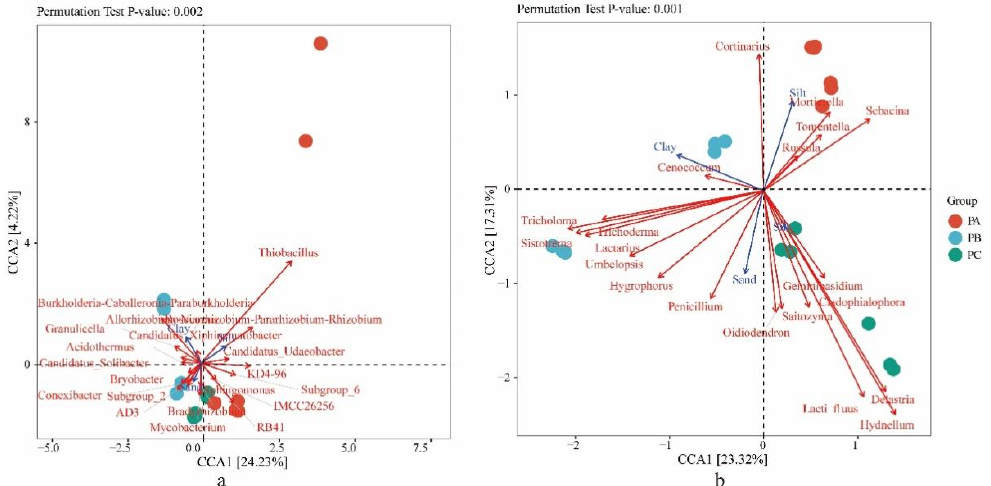
Figure 5. The relationships of soil texture factors with ( a ) bacteria and ( b ) fungal communities in soil with different collection sites. PA, soil samples from plot A; PB, soil samples from plot B; PC, soil samples from plot